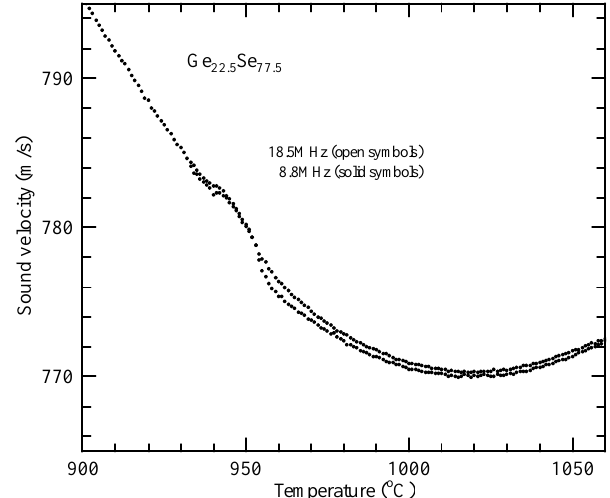
Fig. 4. Sound velocity in liquid Ge 22.5 Se 77.5 measured with different frequencies. in the cooling process (blue symbols) is compared with those measured in the heating process (red sysmbols). Slight hysteresis can be seen in the temperature interval between 921 and 926 o C (GeSe 2 ). An arrow indicates the position of step-wise change, T x . Numbers are at.% of